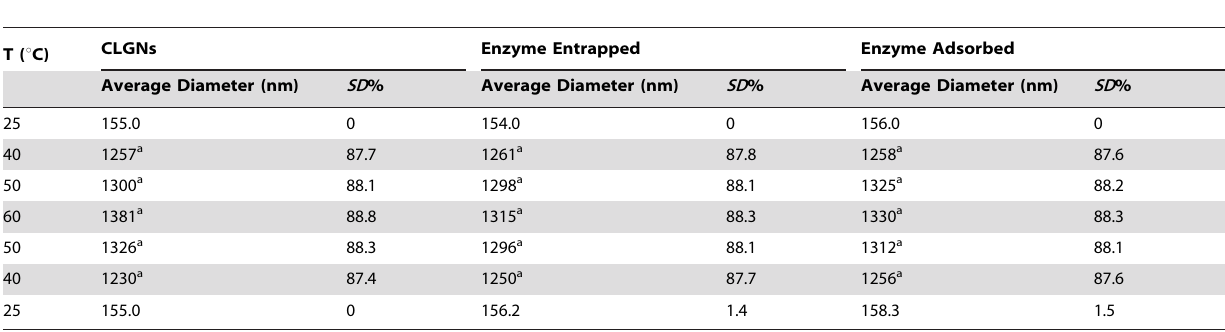
Table 2. Reversible Temperature-Triggered Swelling Degree of the CLGNs, gulocoseamylase immobilized CLGNs prepared by entrapment and adsorption methods respectively.